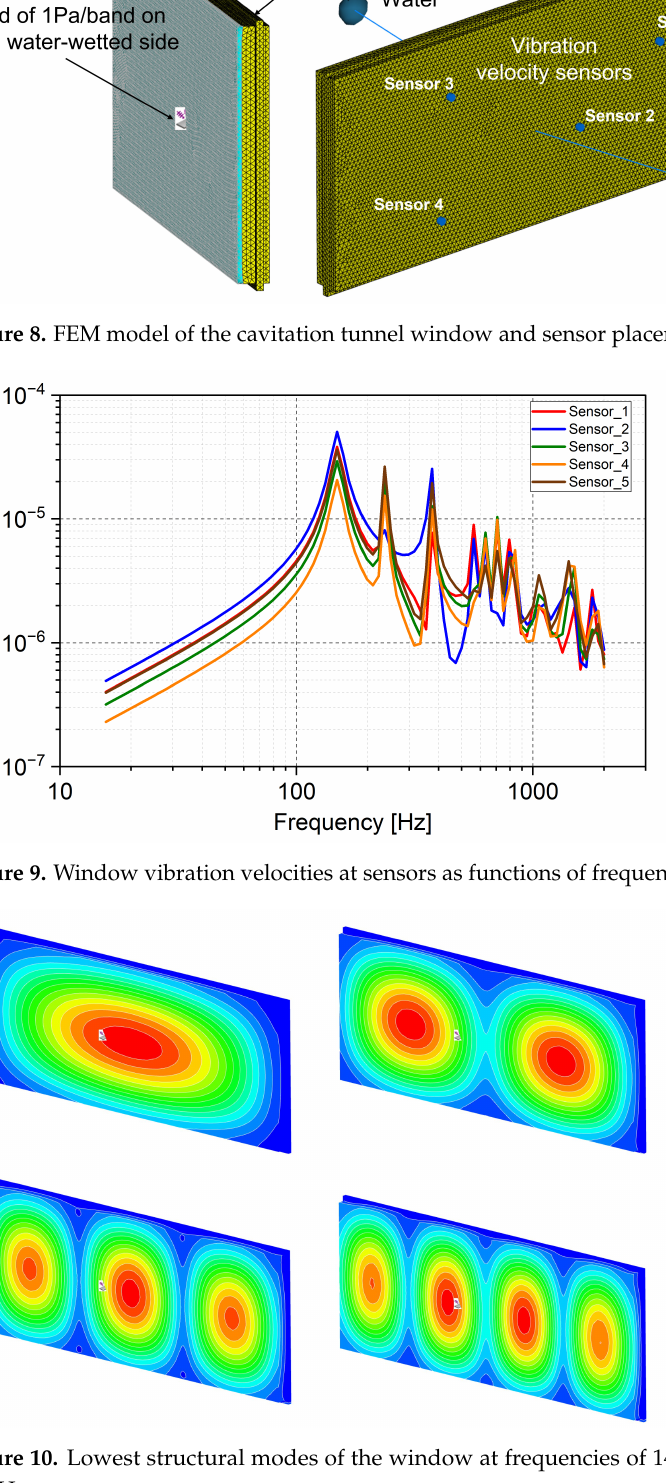
Figure 10. Lowest structural modes of the window at frequencies of 148 Hz, 236 Hz, 374 Hz, and 561